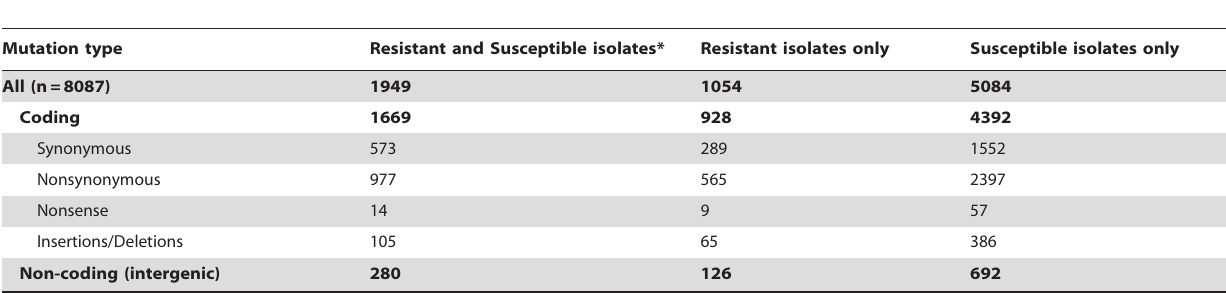
Figure 2. Flowchart showing the steps used for identifying INH-resistance associated genes and intergenic regions. The whole genome sequences of 29 Mycobacterium tuberculosis isolates were aligned with the reference genome H37Rv (GenBank accession no. AL123456.2) and mutations in the sequences were identified. Phylogenetic analysis was carried out to eliminate phylogenetically related mutations. The Poisson and Normal distributions were used to identify mutations associated with INH-resistance. doi:10.1371/journal.pone.0102383.g002 Table 1. Variants identified by whole genome sequencing of 12 isoniazid-resistant and 17 isoniazid-susceptible Mycobacterium tuberculosis